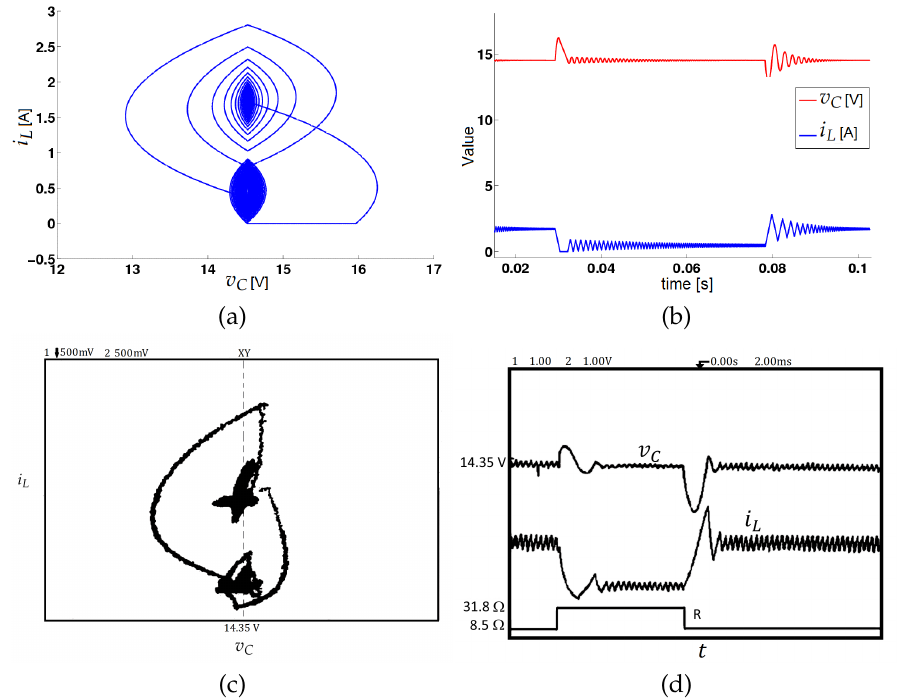
Figure 22. Comparison of simulation and experiment of the zero hysteresis control when the load increases and decreases, and the reference voltage is V ref = 14.53 V for a ( a ) simulated phase diagram, ( b ) simulated temporal evolution, ( c ) experimental phase diagram, and ( d ) experimental temporal